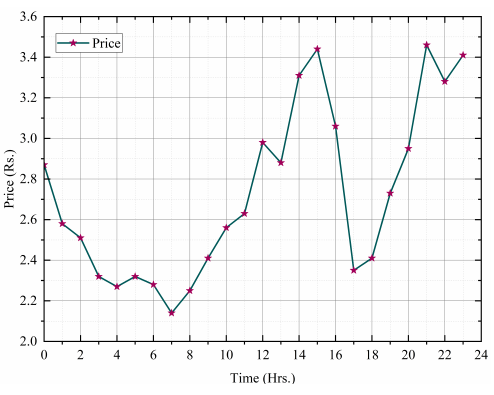
Figure 4. Electricity price